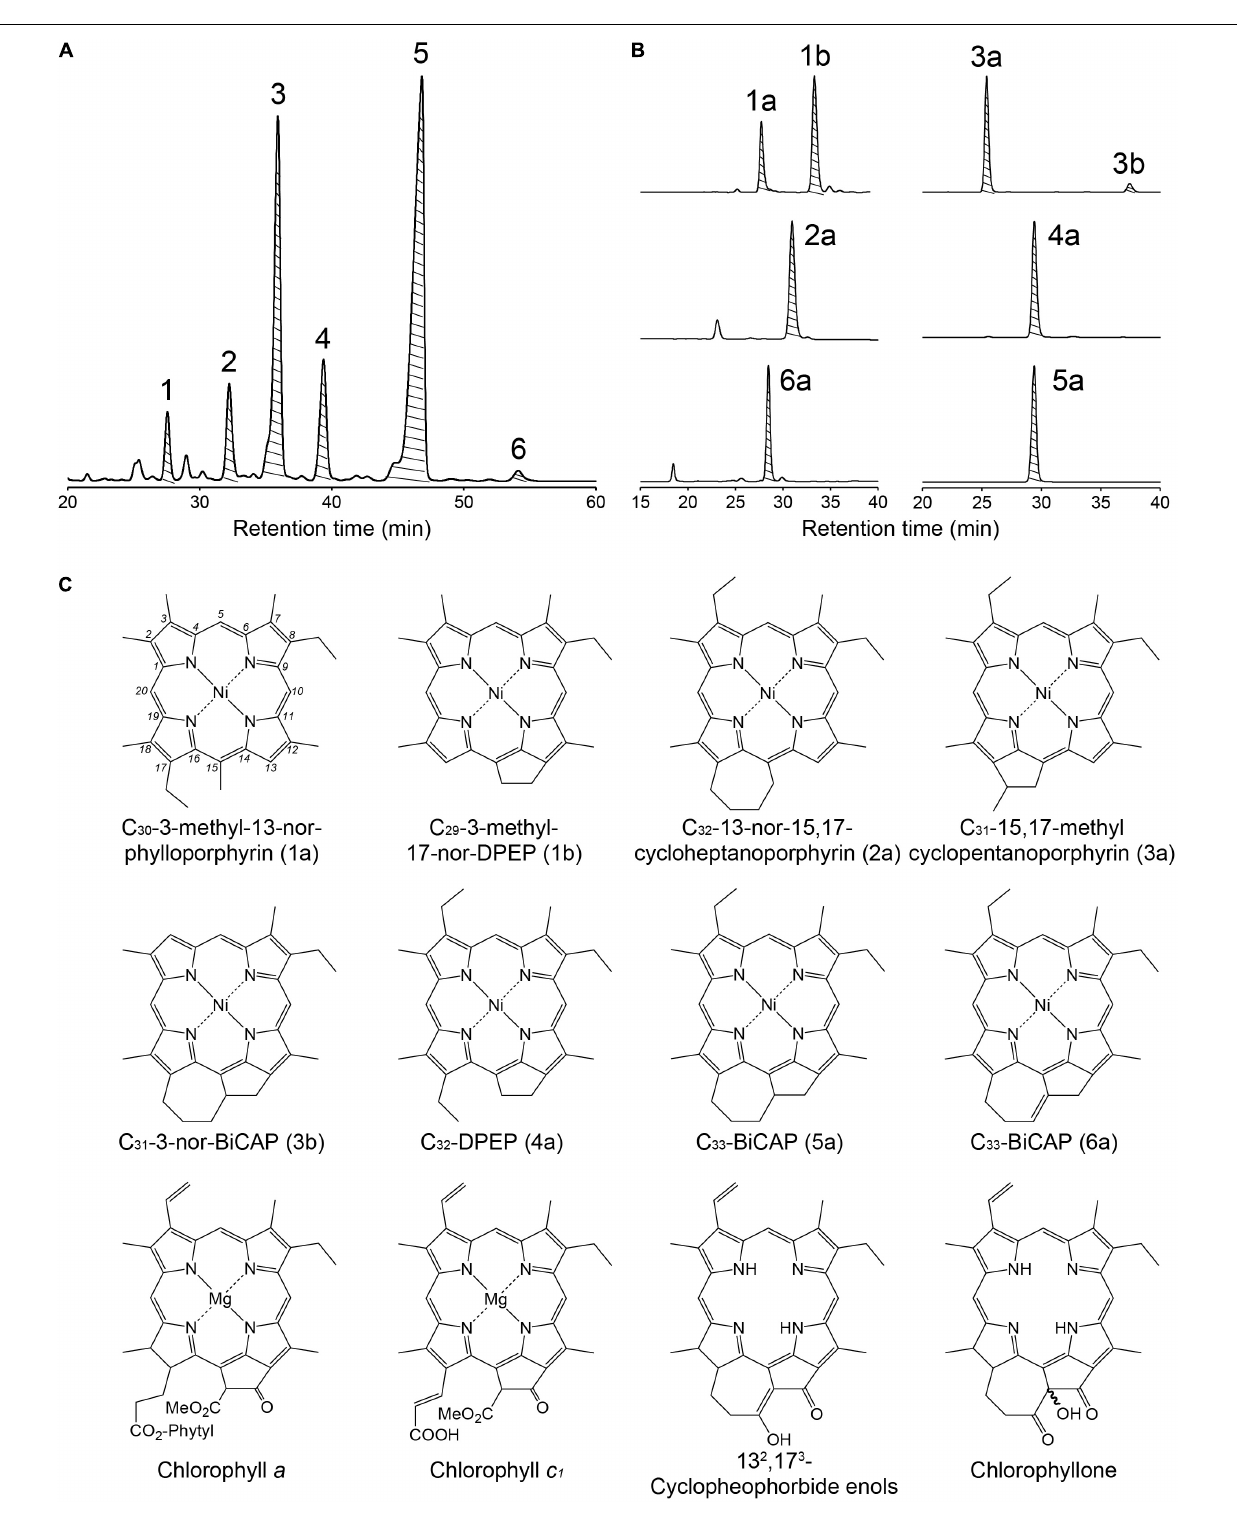
Frontiers in Earth Science |